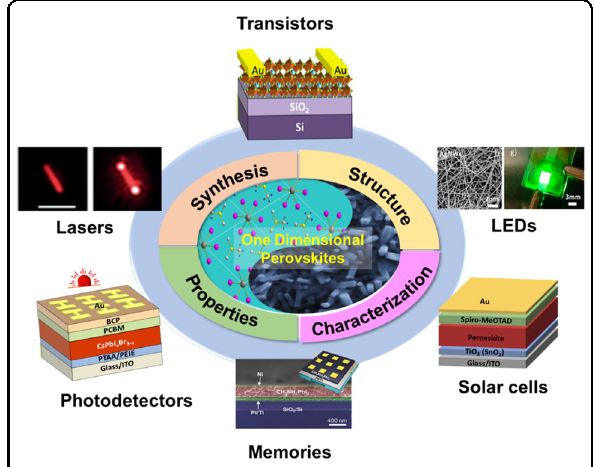
Fig. 1 Potential applications for 1D MHP. Schematic illustration of one-dimensional metal-halide perovskites with optoelectronic